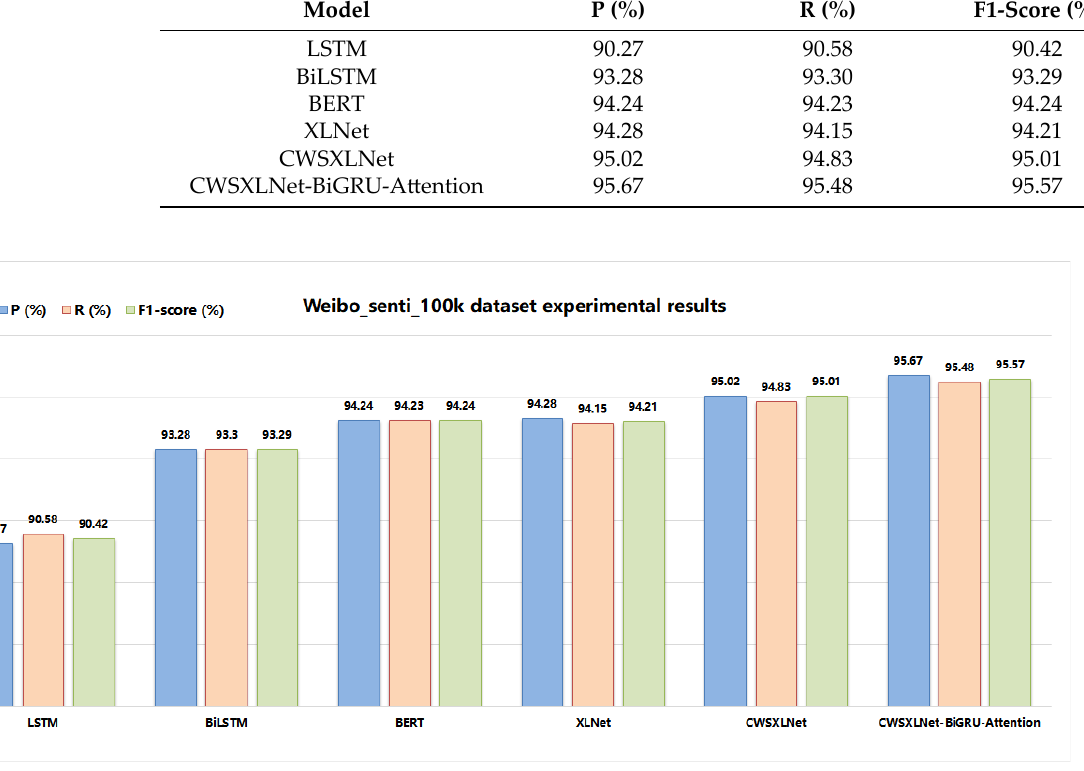
16 of 18 Figure 13. ChnSentiCorp dataset experimental results.